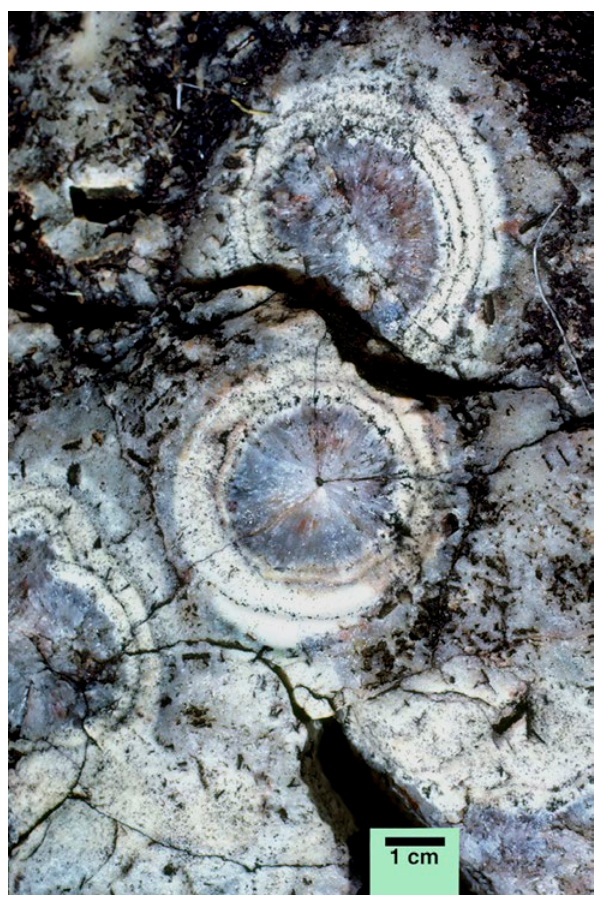
Figure 59. At the precursor stage, denser concretionary polymeric silica precipitated around dawsonite needles grown in the pre- crystalline silica gel. The denser concretionary silica subsequently crystallised to form a radiating spherulitic pattern of crystallisation which now forms tubular shaped clusters of radiating fine crystals round the nucleating dawsonite needles. The concentric banding or zones probably represent concretionary desorption of impurities (Liesegang-type) prior to crystallisation. The outcrop is at Mt. Gee in the Flinders Ranges,